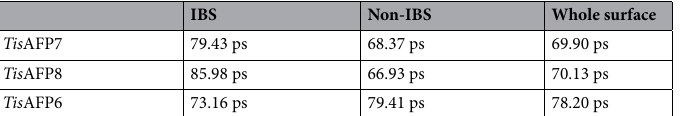
Table 2. Water residence time for Tis AFP isoforms on the molecular surface. The values were estimated for water molecules making hydrogen bonds with IBS residues (positions 19–25, 38–45, 123–129, 147–153, 174–180, 192–198, and 210–216), and non-IBS residues, and all